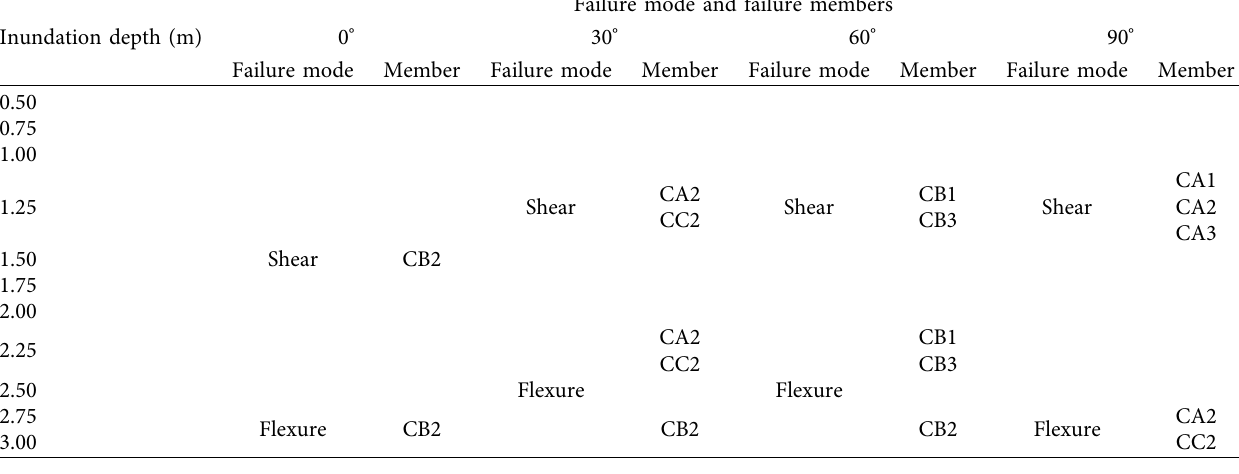
Table 4: Failure mode and failure members of all fow direction